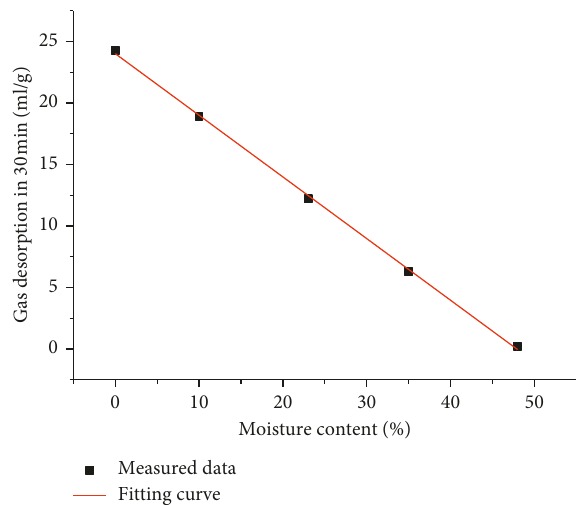
Figure 6: Curve of the gas desorption amount per unit mass in 30min versus the